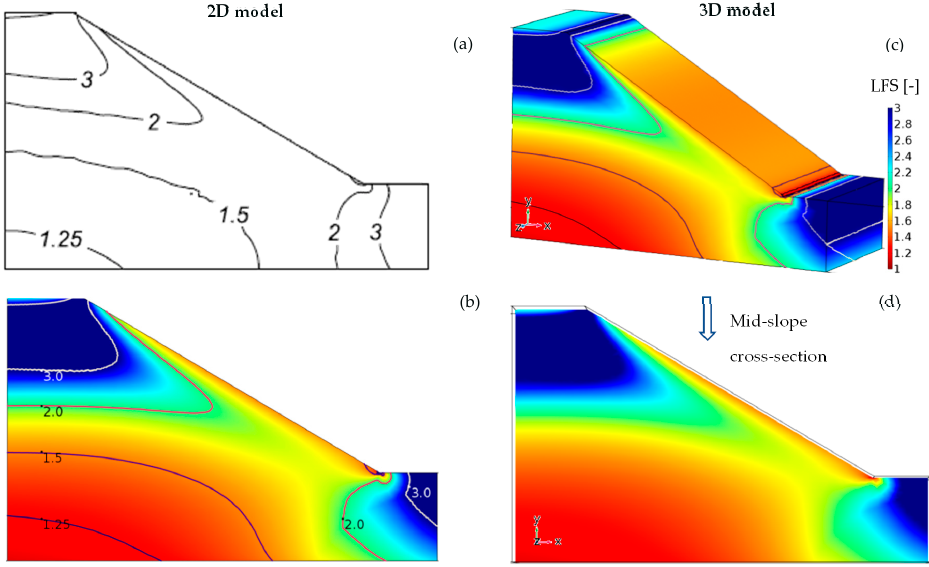
Figure 7. The simulated LFS distribution of ( a ) Lu et al. [30], and our COMSOL implementation in ( b ) 2D, ( c ) 3D, and ( d ) a cross-section through the 3D model.